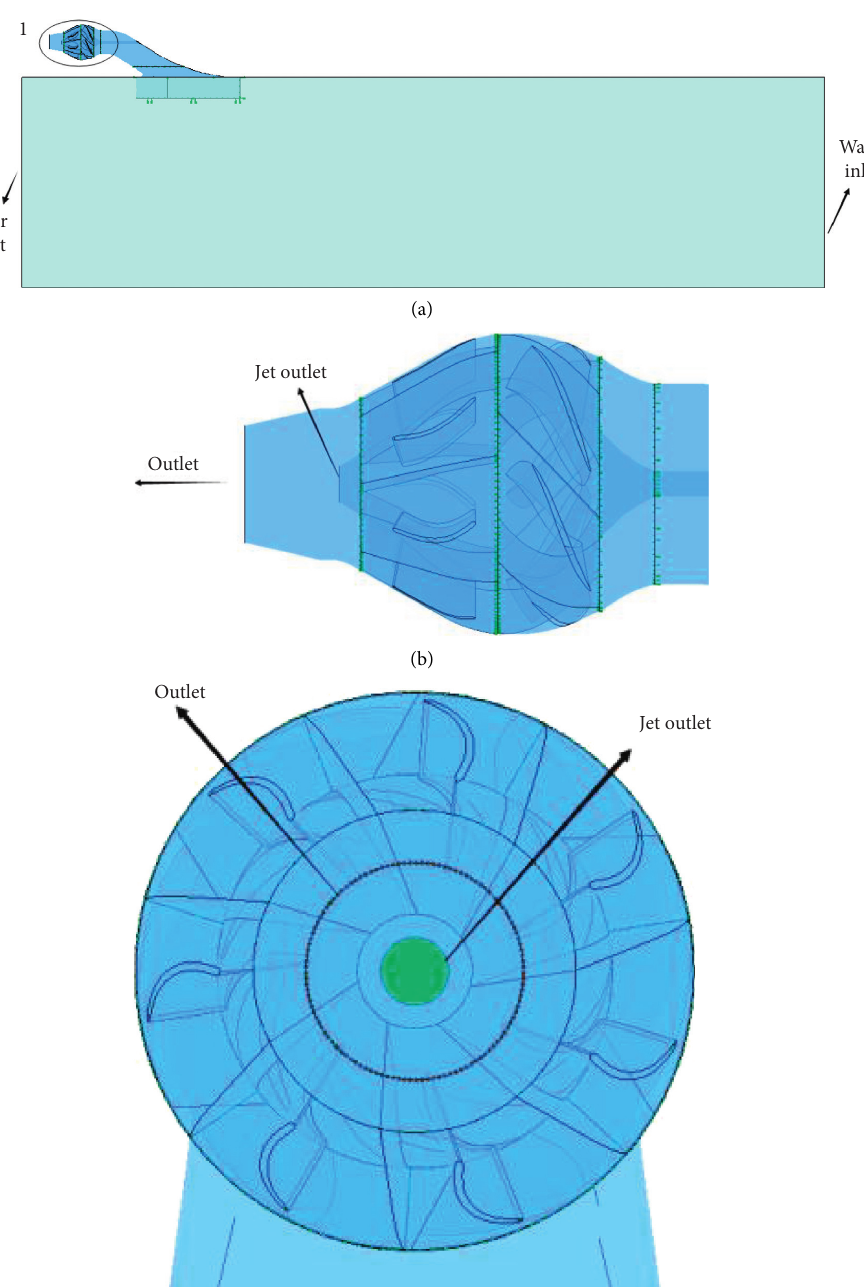
Figure 2: Computational domain. (a) Overall picture. (b) Partial enlarged view. (c) Partial enlarged